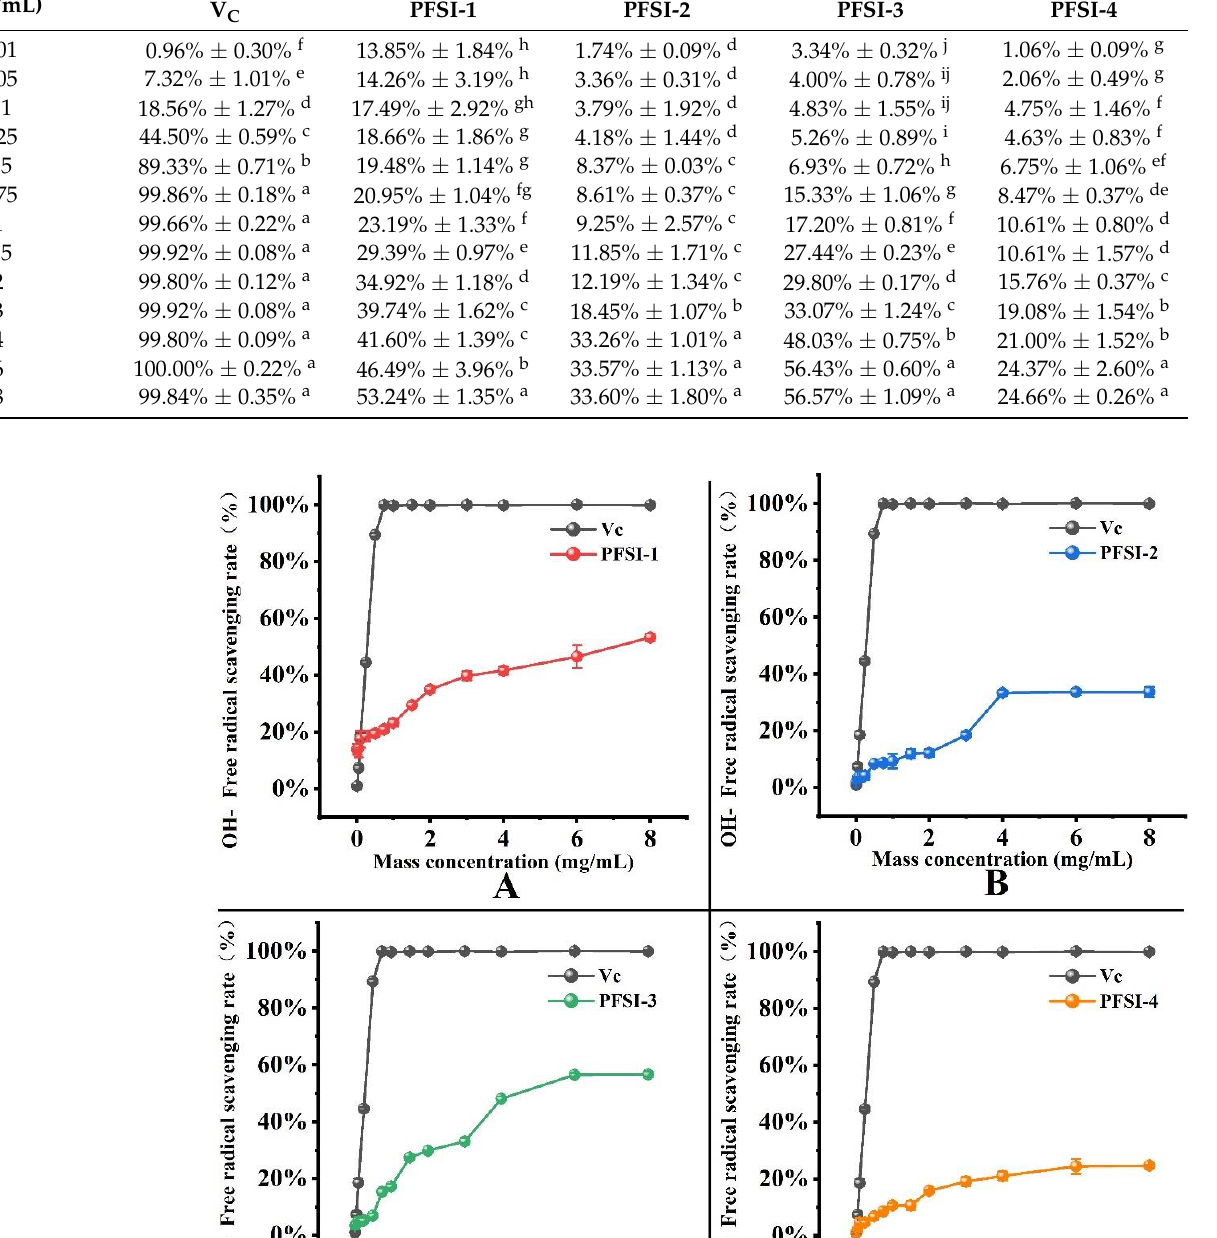
ical scavenging rates. At a concentration of 0.05 mg/mL, PFSI-2, PFSI-,3 and PFSI-4 ABTS· radical scavenging rates reached a plateau. The ABTS· radical scavenging rate of PFSI-1 plateaued at a concentration of 0.1 mg/mL. At concentrations of 1.0~8.0 mg/mL, the ABTS· radical scavenging capacity of PFSI-4 was slightly higher than that of V C . When concen- trations of 0.01~8 mg/mL were compared by the magnitude of the maximum ABTS· scav- enging rate, there was almost no difference between V C and PFSI-1, PFSI-2, PFSI-3, or PFSI-4. It was demonstrated that all had some ABTS· radical scavenging ability.